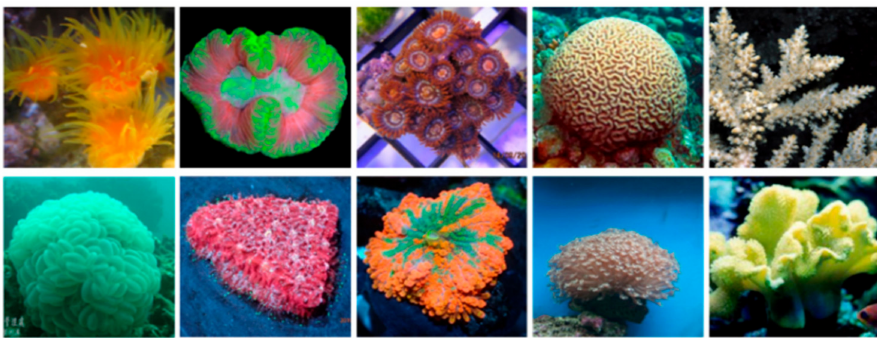
Figure A7. Examples of coral images that were collected through python